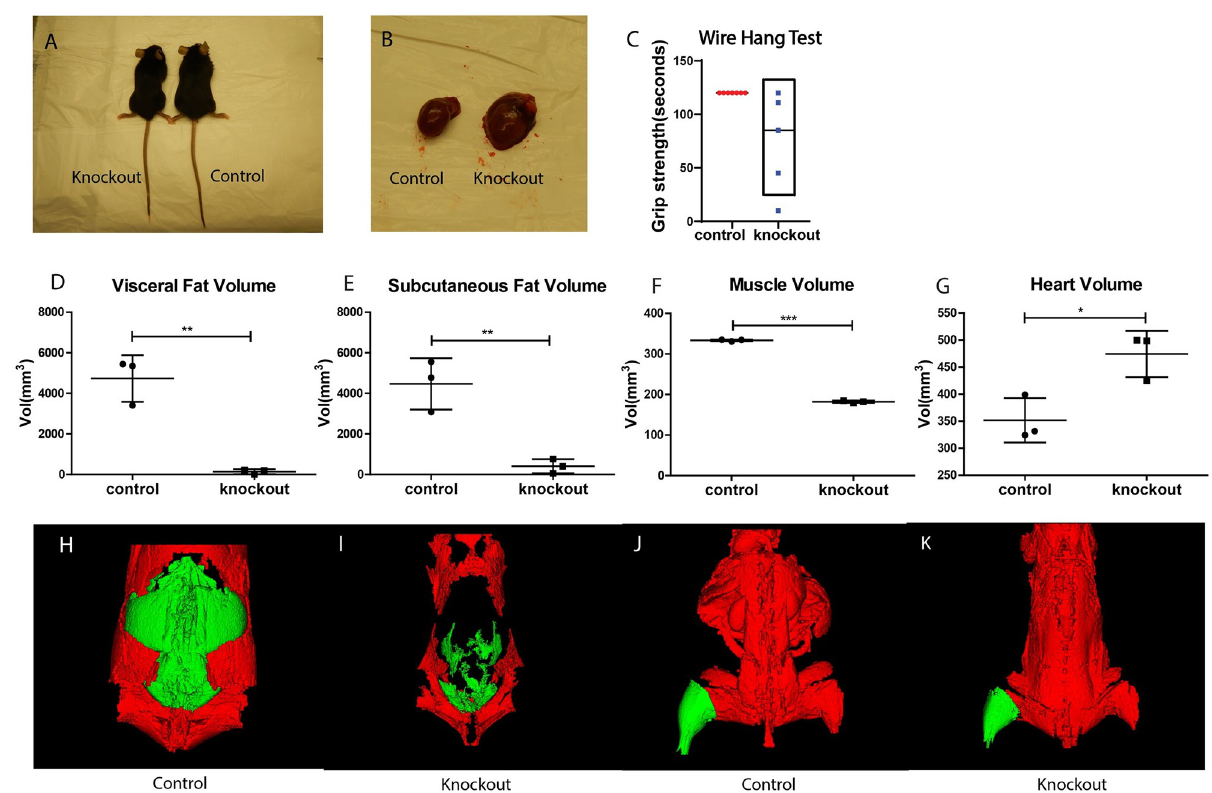
Fig 2. Fat and muscle volume. (A-B) Picture of control and knockout mice (A), and heart (B). (C) Wire hang test results differs around 16 weeks. n = 5 mice per group. Visceral fat (D), subcutaneous fat (E), leg muscle volume (F) and heart volume (G) of control and knockout mice. n = 3 mice per group. Data are shown as means ± S.D. Groups were compared using the Mann-Whitney U -test. (H-K) CT scan of fat and muscle volume, visceral fat showed in green and subcutaneous fat in red (H-I), and leg muscle in green (J-K). All the data were taken from 16 weeks mice. Significant levels were set to p < 0.05( � ), p < 0.01( �� ), p < 0.001( ���